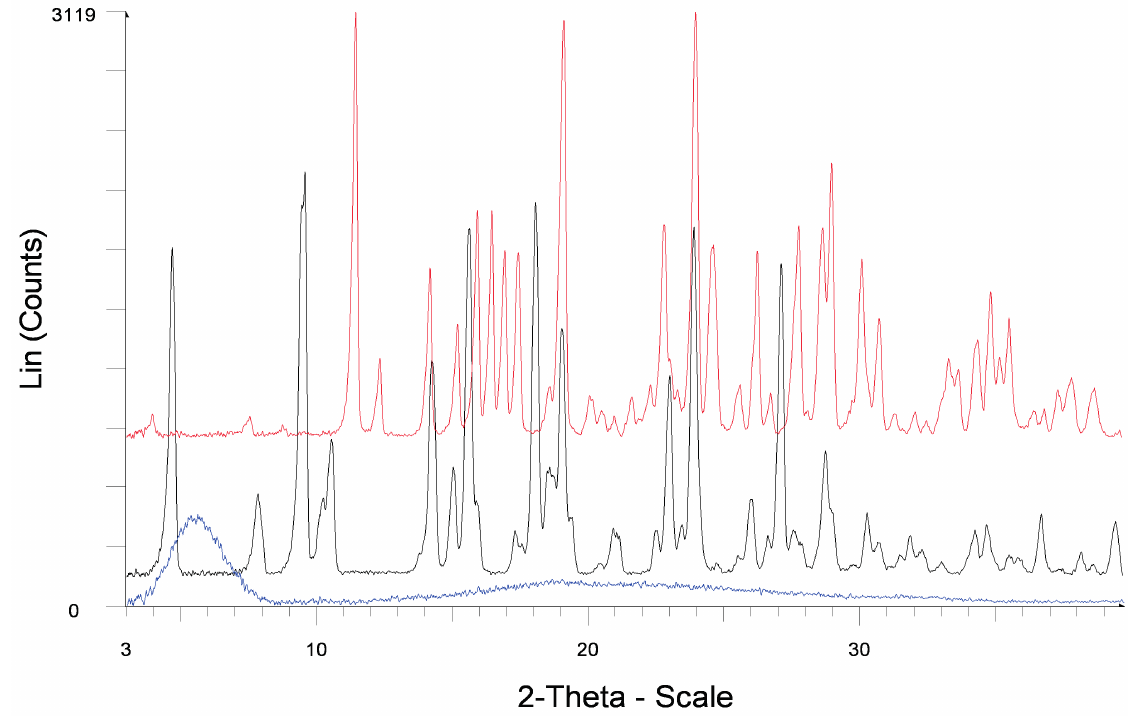
Figure 5. PXRD patterns of HT-PE ( red line ), HP-PE ( black line ) and AM-PE ( blue line